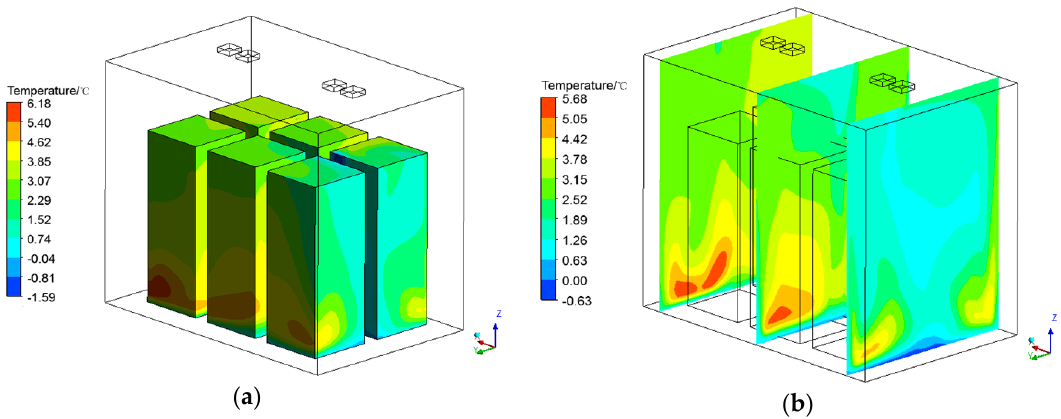
Figure 8. ITCC temperature distribution ( a ) on the produce surface and ( b ) in the container.